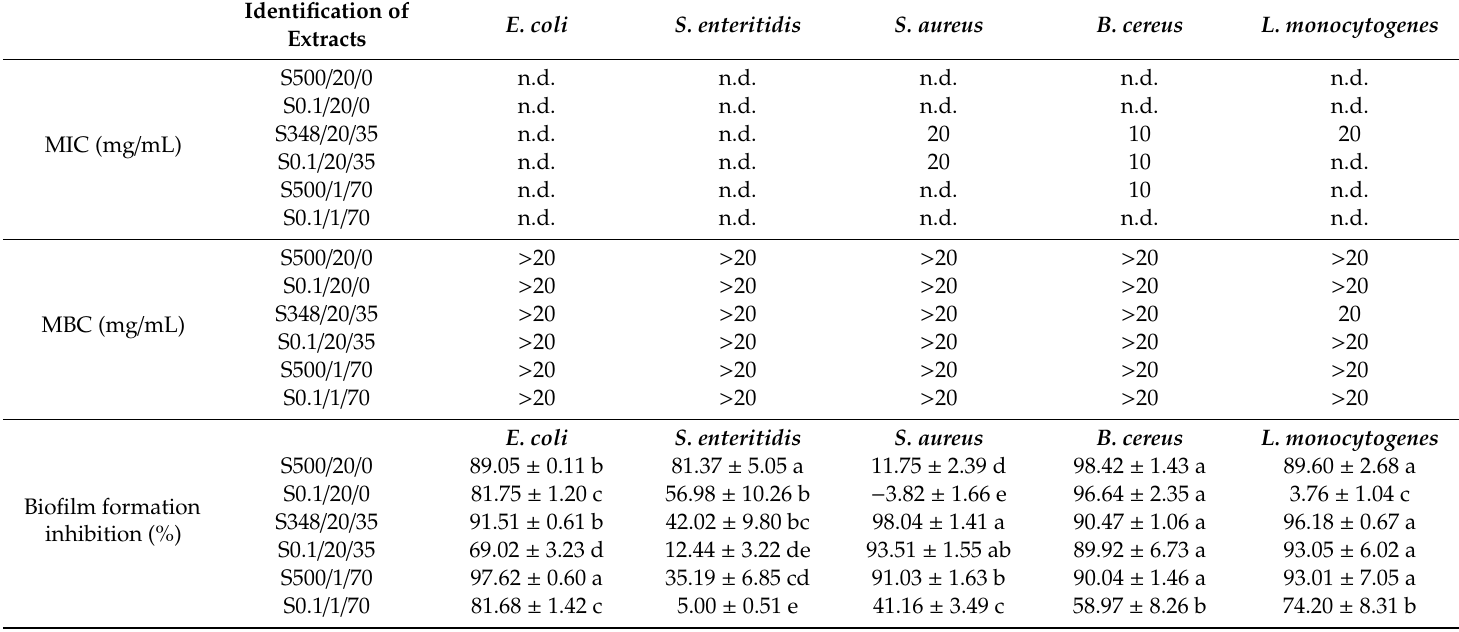
Table 3. Minimum inhibitory concentration (MIC), minimum bactericidal concentration (MBC), and biofilm formation inhibition capacity of winter savory leaves extract against pathogenic bacteria commonly found in food products. Di ff erent letters indicate significant di ff erences ( p < 0.05) between extracts for each assay (analysis by